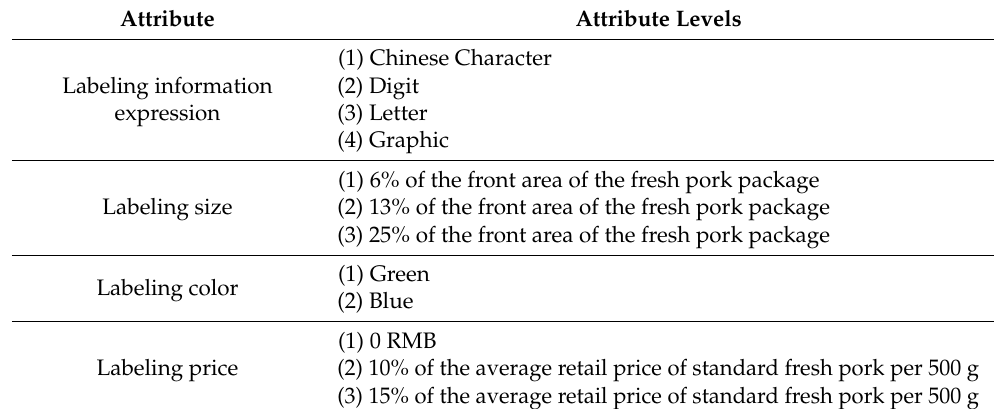
Table 1. Attributes and levels set in the choice.